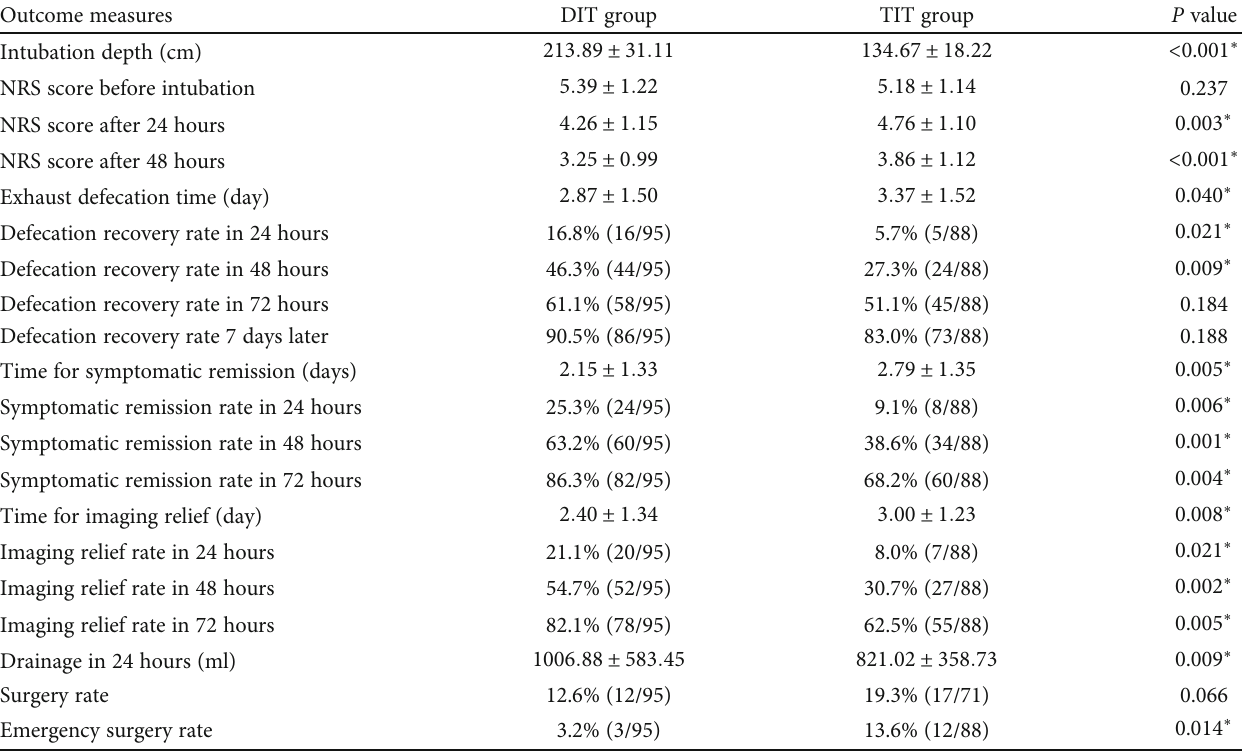
Table 2: Short-term outcomes of DIT group and TIT group.